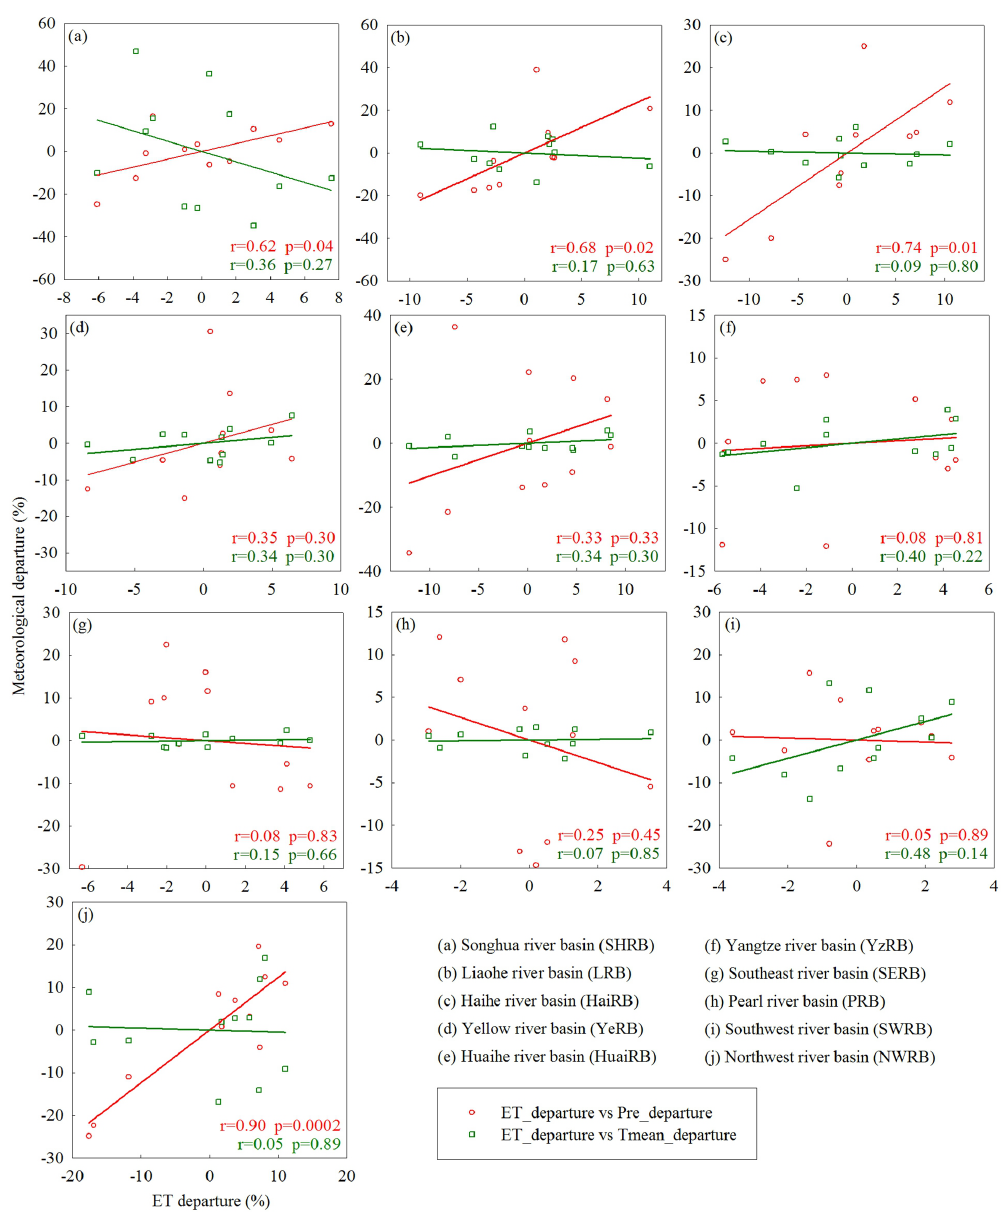
Fig. 13. Correlations of the departures of basin-level annual ET with the departures of precipitation and